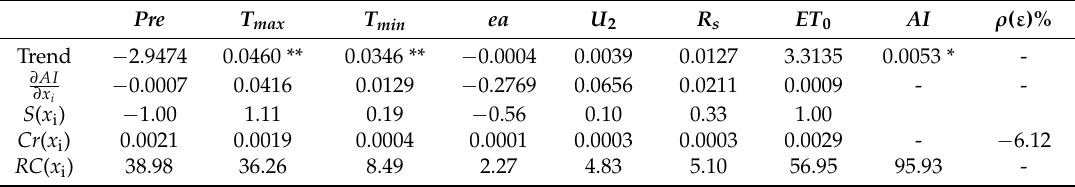
Table 2. Contribution of climate variables to the trends in annual aridity in Southwest China from 1993 to 2015.